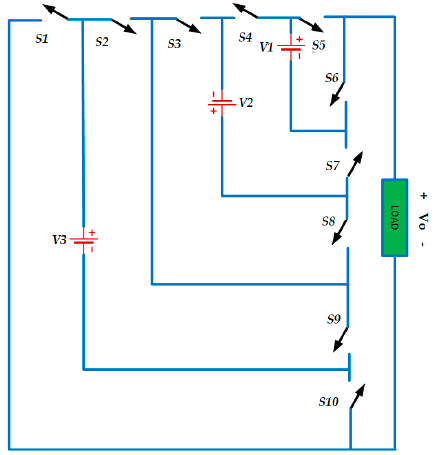
Figure 9. 21 − Level MLI.